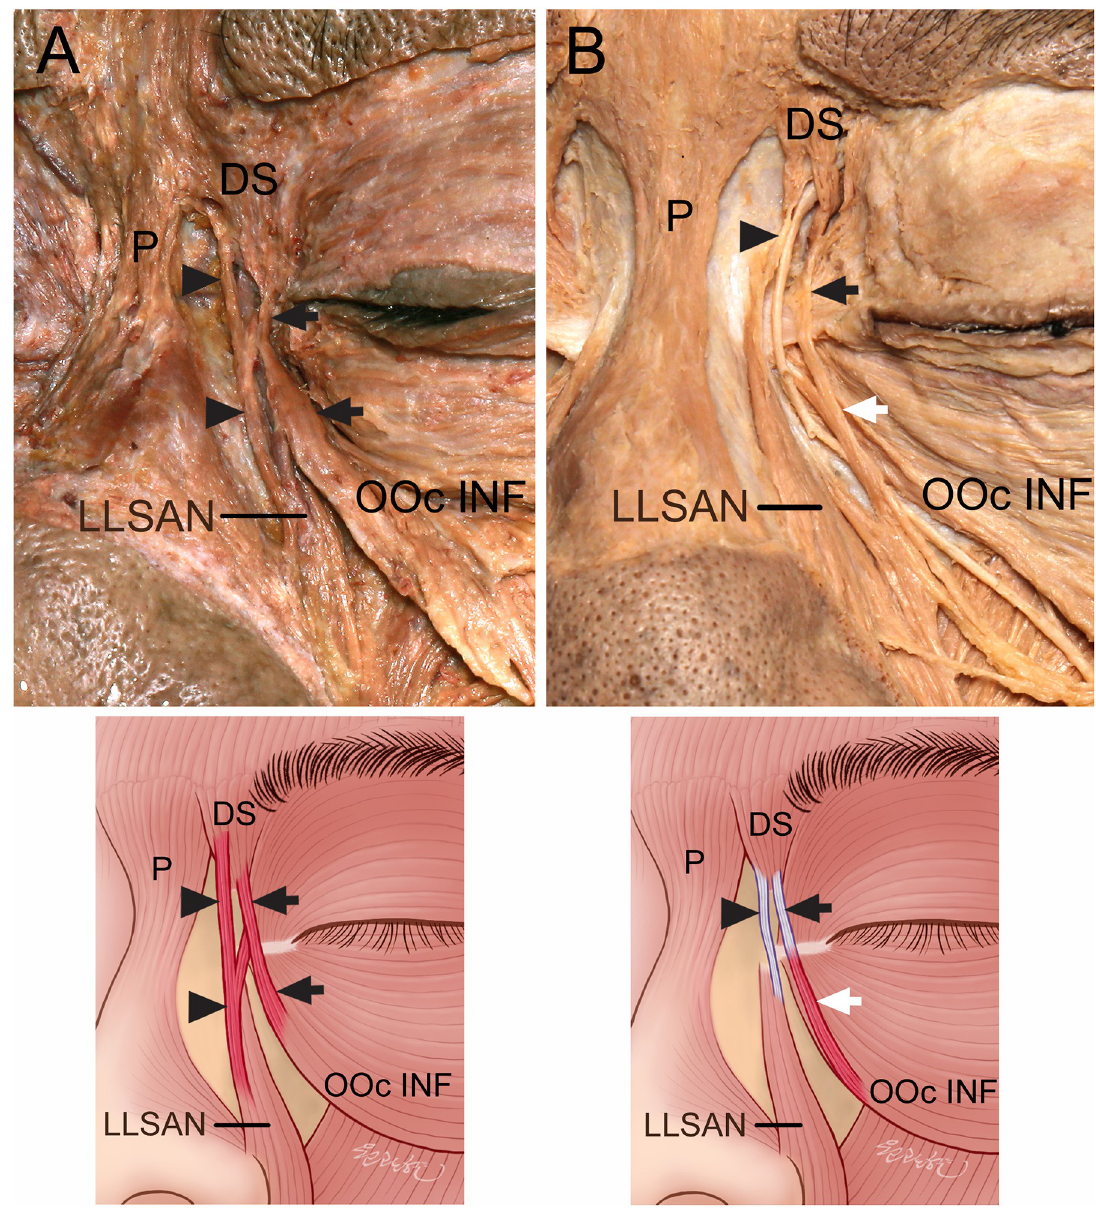
Fig 3. Connections of the DS to both the LLSAN and OOc INF. (A) Connecting muscle fibers were found between the DS and LLSAN (arrowheads) and between the DS and OOc INF (arrows). (B) Connecting aponeuroses were found between the DS and LLSAN (arrowheads) and between the DS and OOc INF (arrows). Some muscle fibers (white arrows) of the OOc INF were connected to the thin aponeurosis (black arrows) coursing on the medial palpebral ligament, and the thin aponeurosis (black arrows) of the OOc INF was connected to the